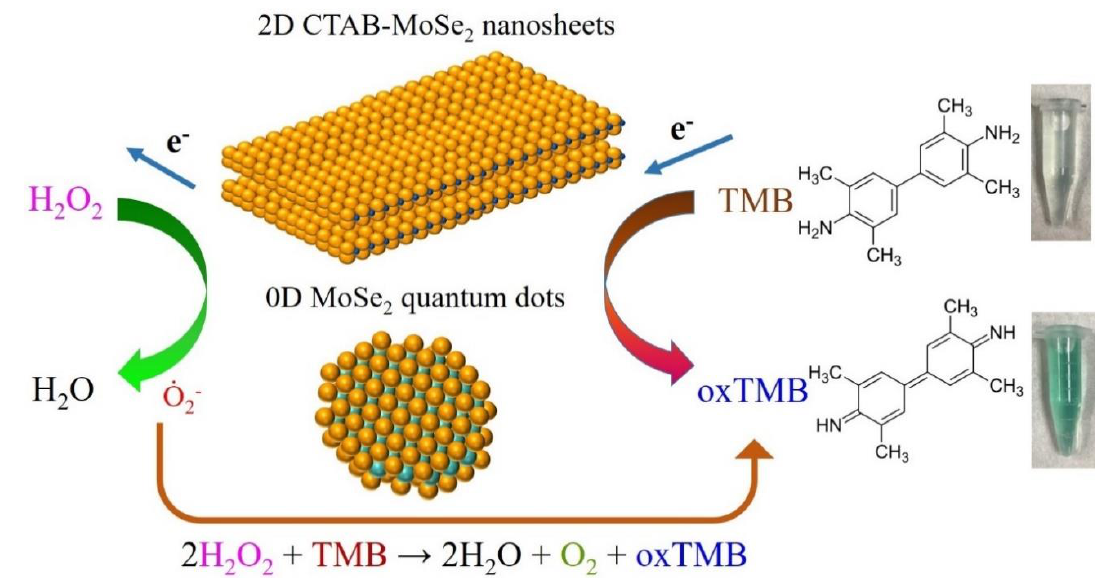
Figure 12. The schematic diagram depicts the mechanism for colorimetric detection of H 2 O 2 by using 2D CTAB-MoSe 2 NSs and MoSe 2 QDs as peroxidase mimetics.